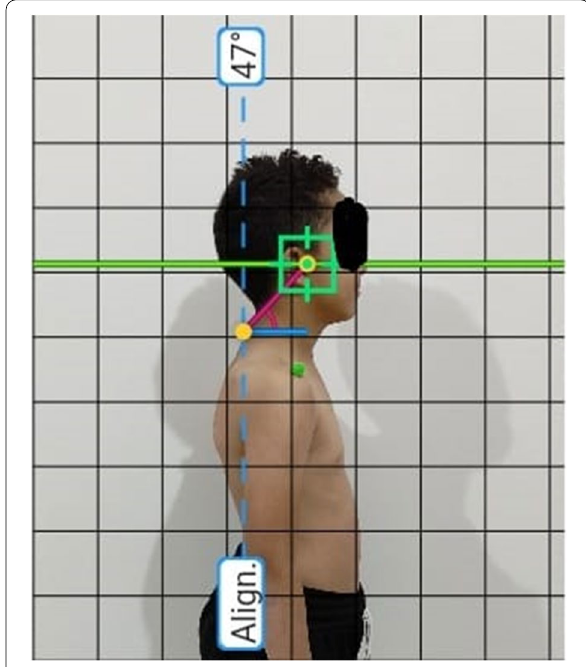
Fig. 1 Measuring CVA (colorful styrofoam balls were placed on C7 and the tragus of the ear)